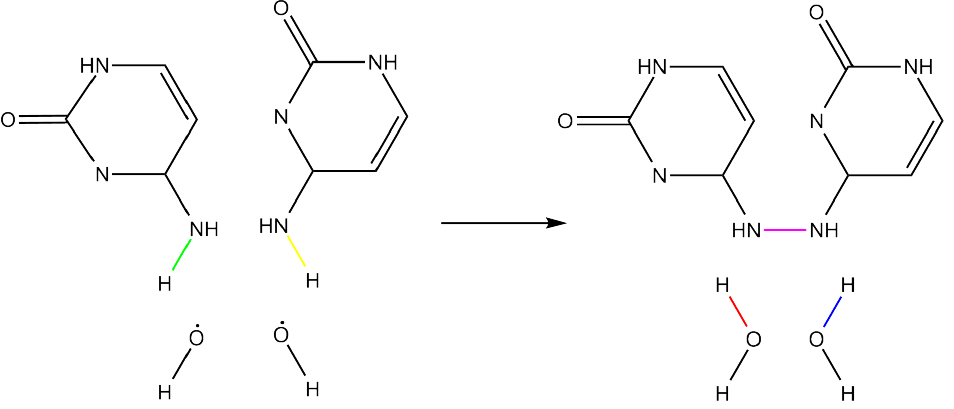
Figure 6. Reaction mechanism which leads to the formation of 2f